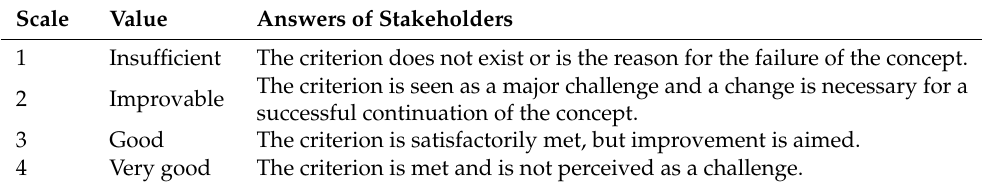
Table 1. Scale of evaluation criteria assigned according to stakeholders’ responses.